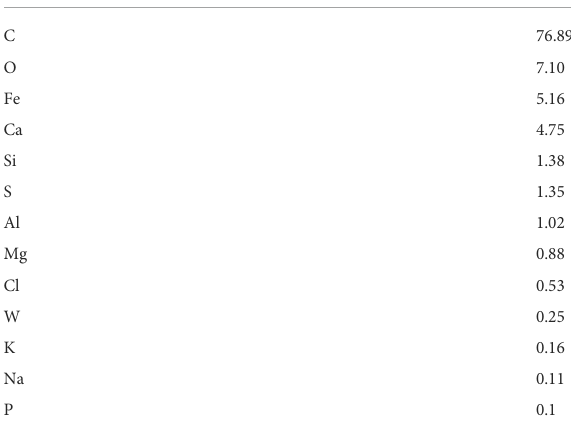
TABLE 2 High-carbon fl y ash elemental composition